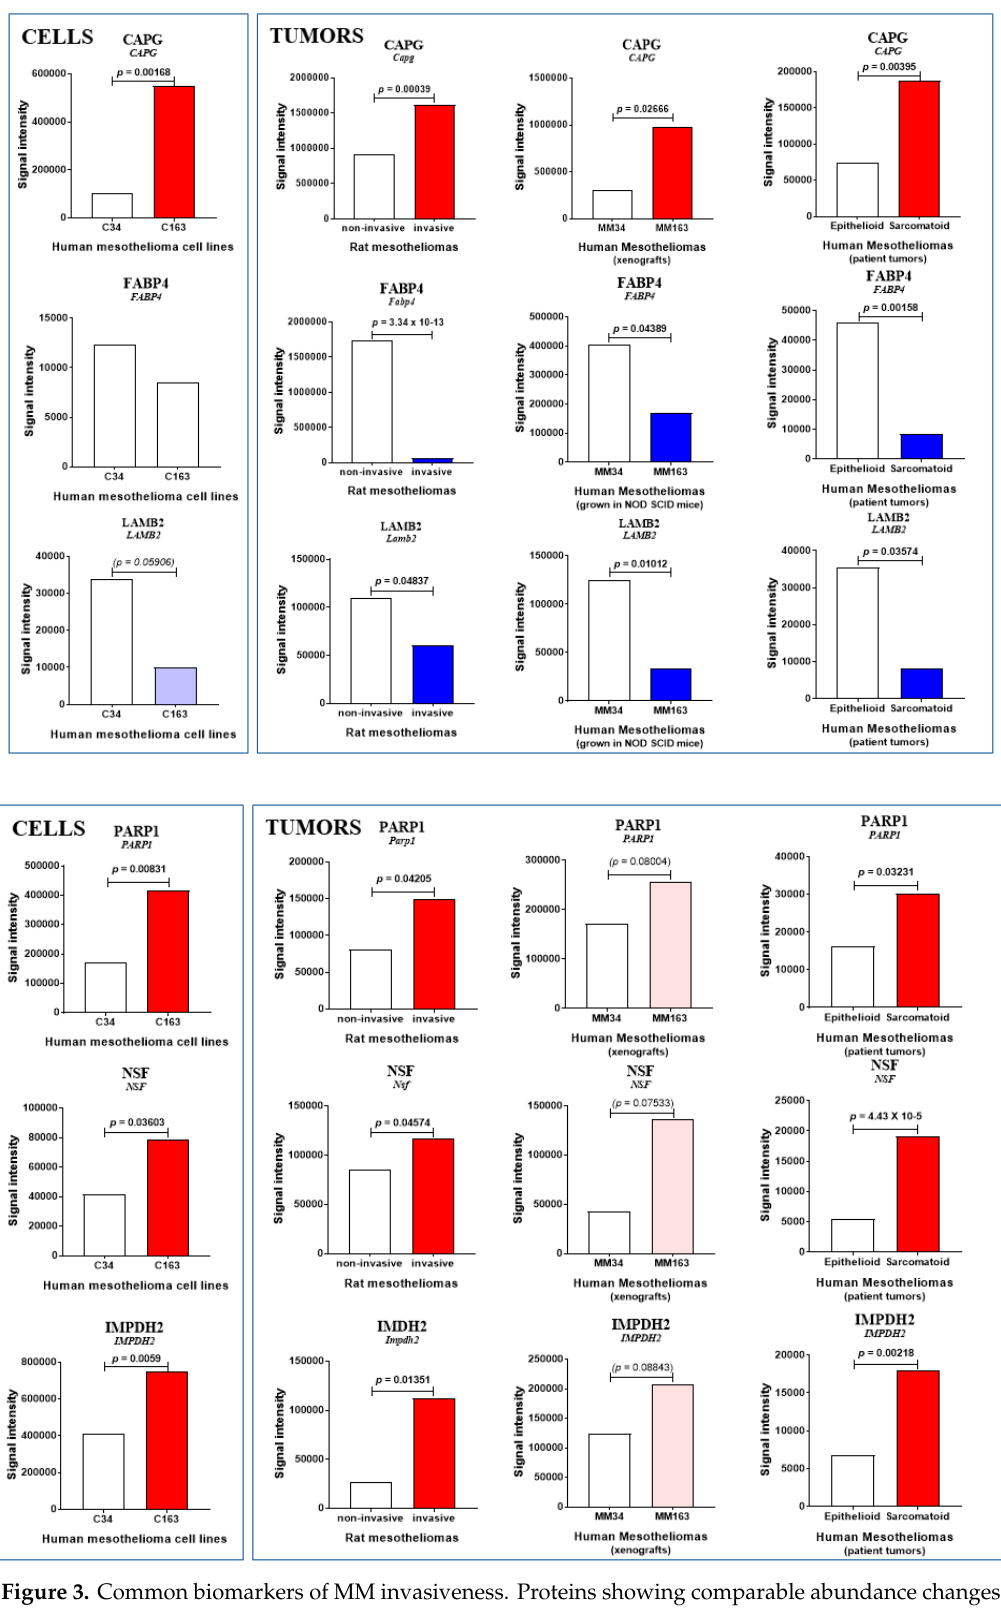
Figure 3. Common biomarkers of MM invasiveness. Proteins showing comparable abundance changes in MM from the three sources and between human mesothelioma cell lines. Increase and decrease are indicated by red and blue bars, respectively (with p values). Blank bars reflect the absence of significant changes ( p > 0.09), while light red or blue bars indicate tendencies (0.05 < p < 0.09).